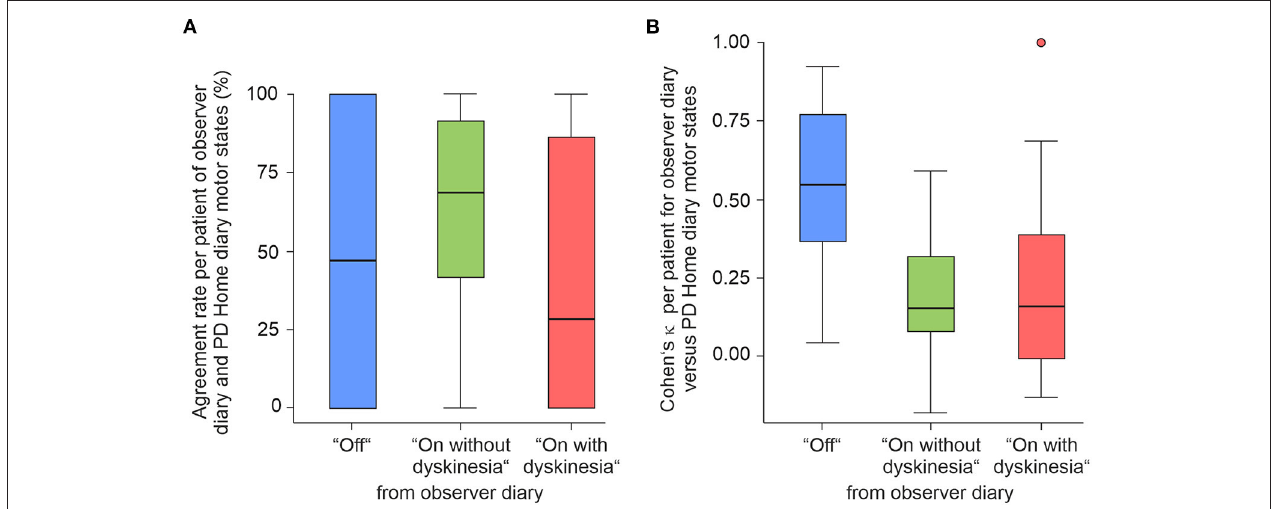
FIGURE 3 | Temporal agreement of observer-documented and PD Home diary ratings on the participant level. Agreement rates (A) and Cohen’s κ values (B) for “Off”, “On without dyskinesia” and “On with dyskinesia” based on simultaneous half-hourly ratings of 40 participants from two consecutive days (8 am to 4 pm) and independent observer ratings serving as reference for the comparison. Boxplots are shown with a central mark at the median, bottom, and top edges of the boxes at 25th and 75th percentiles, respectively, whiskers out to the most extreme points within 1.5 times the interquartile range, and outliers scoring more than 1.5 at most 3 IQR outside the quartiles. PD, Parkinson’s disease; IQR, interquartile range. ×